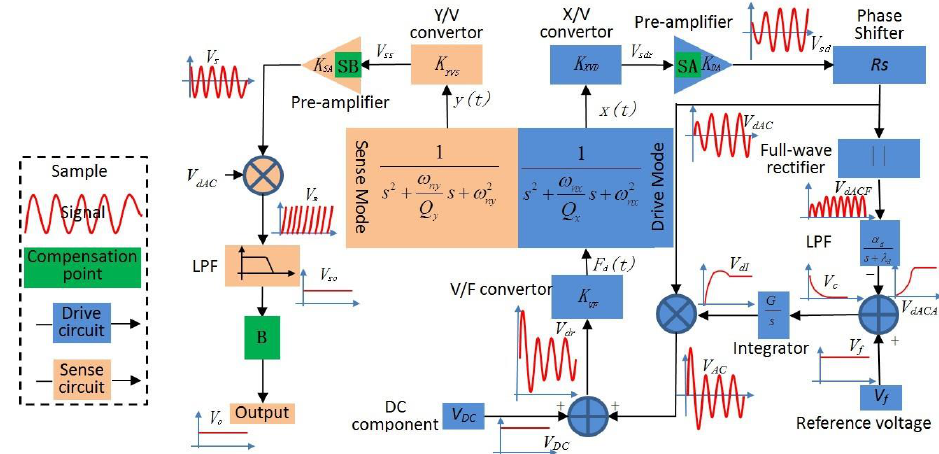
Figure 3. Gyroscope’s peripheral circuit and the signal flow.